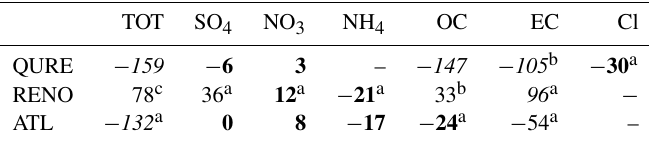
Table 4. Phase shift ( n) of CMAQ-simulated annual cycle components in days. The bold font shows the number of shifts of less than a month, while the italics show shifts of longer than 3 months.